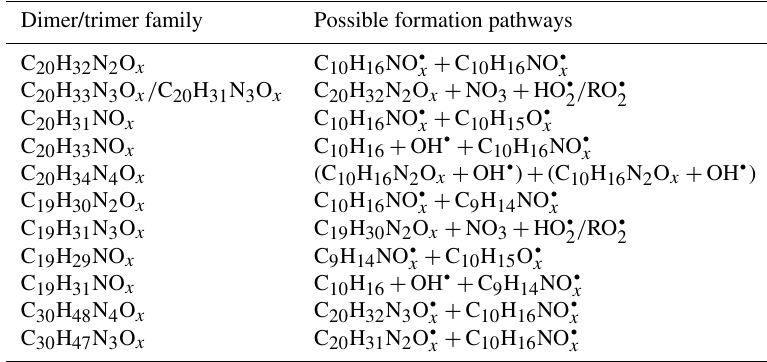
Table 2. Major dimer and trimer families and their possible formation pathways. Dimer/trimer